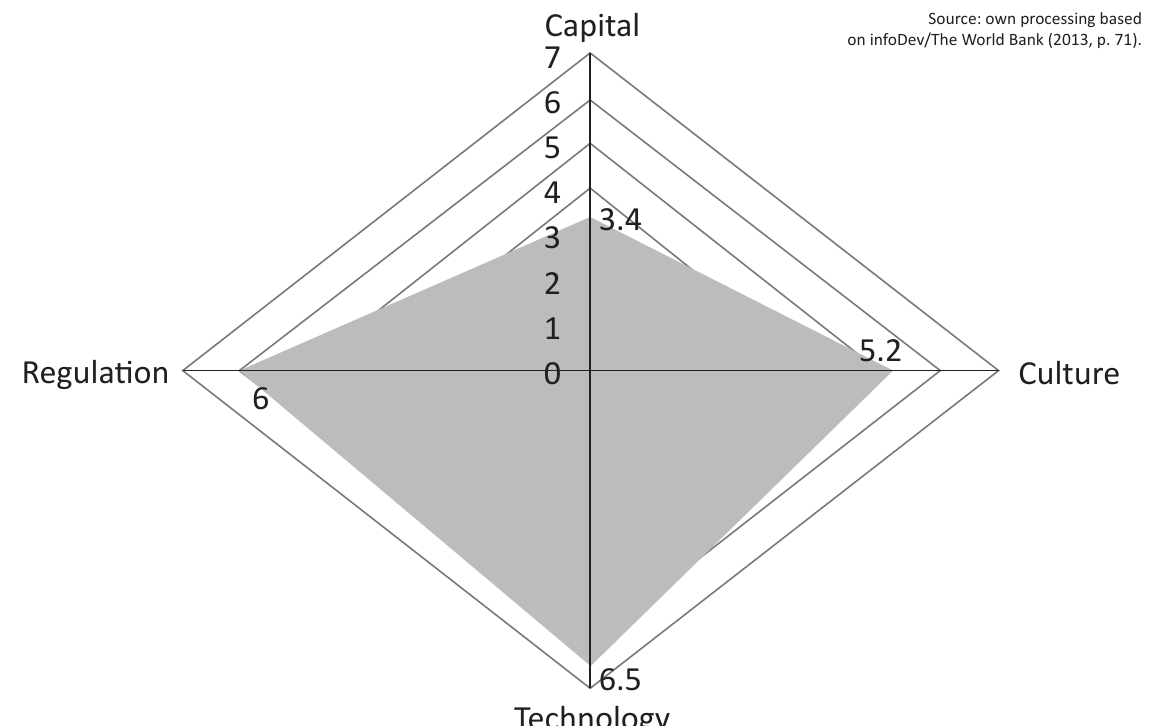
Figure 2. Visualiza�on of Ukraine’s readiness for